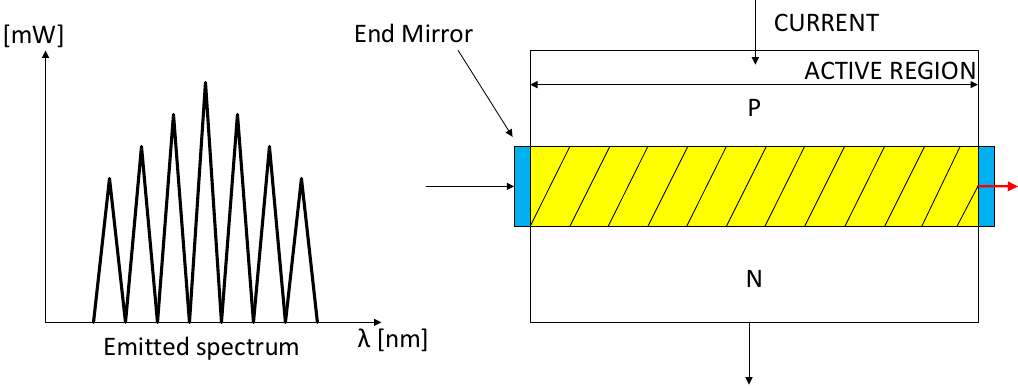
Figure 6. Schematic diagram of the FP